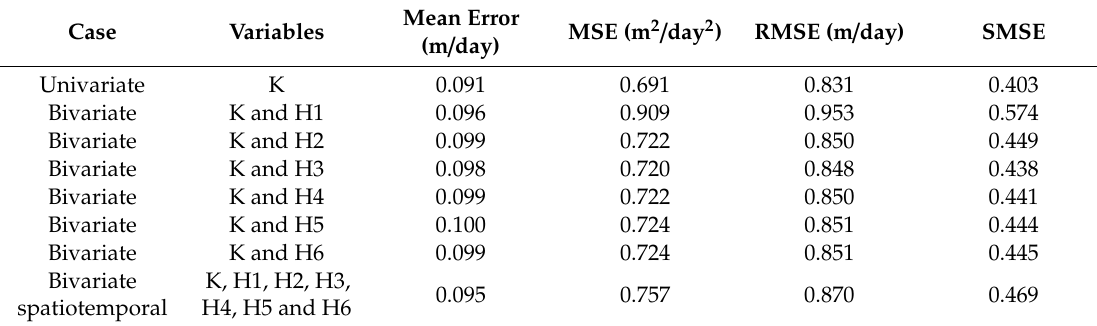
Table 8. Estimation errors of K.